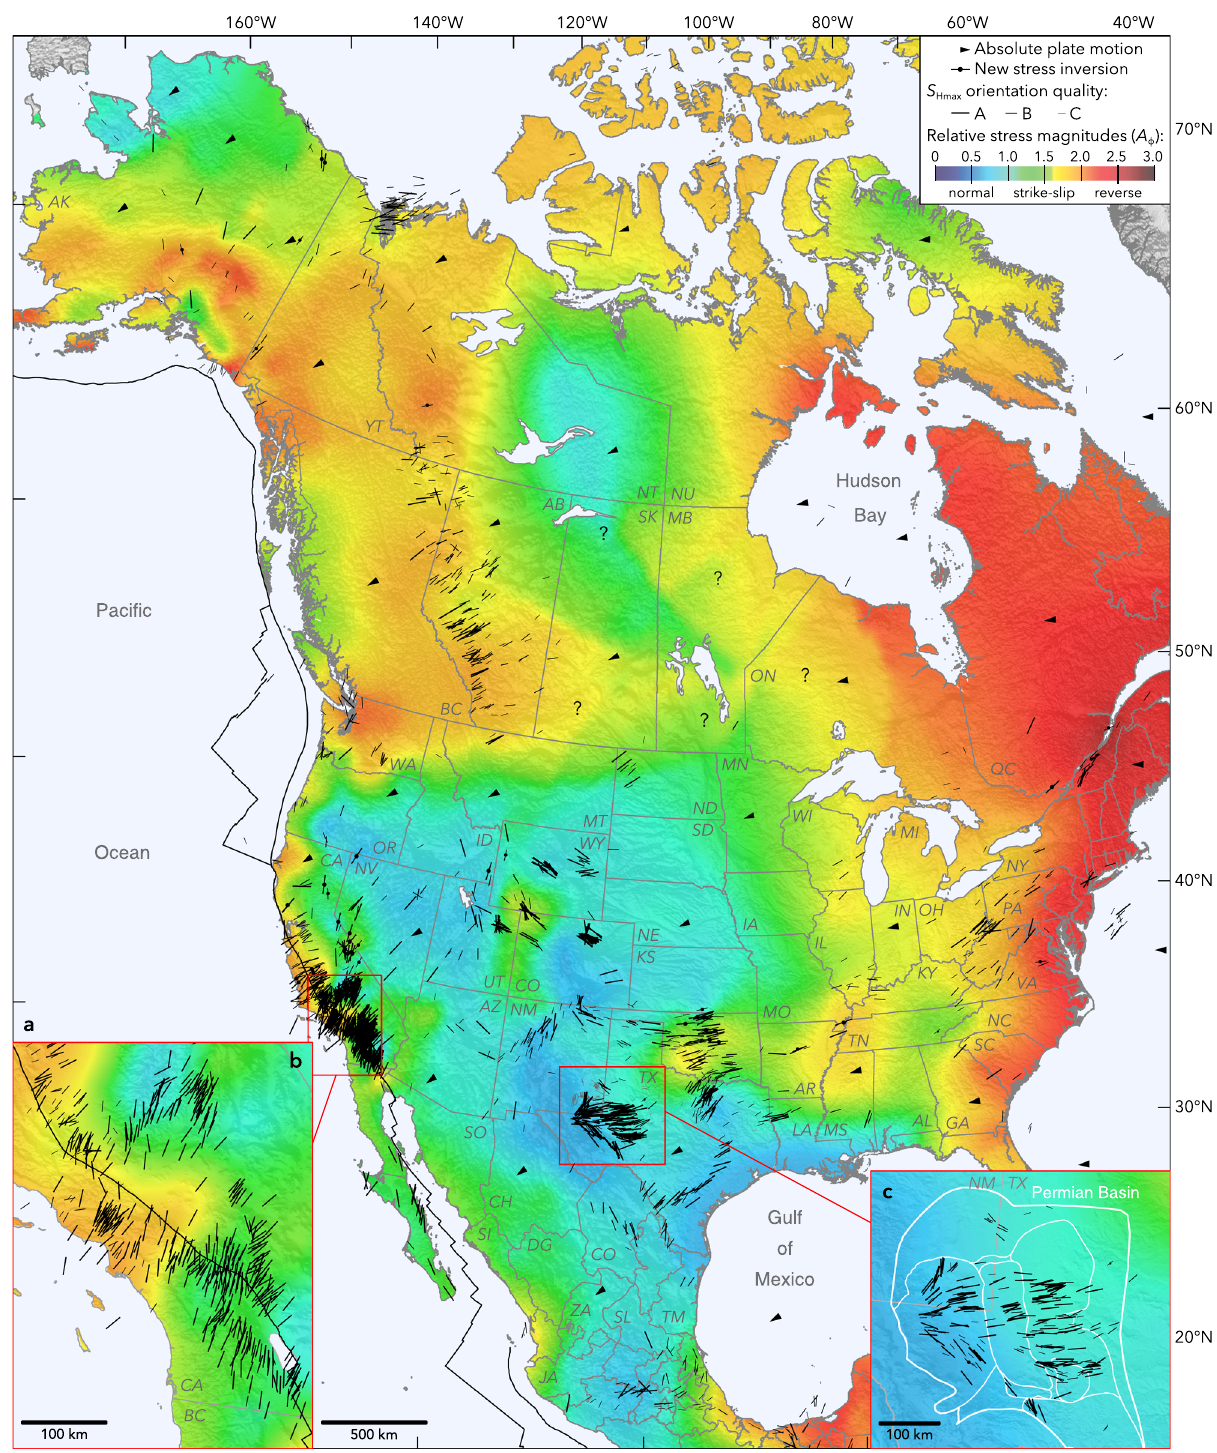
Fig. 1 State of stress in North America. Black lines are maximum horizontal stress ( S Hmax ) orientations and the colored background is the style of faulting (relative stress magnitudes) compiled from new and previously published measurements (see the text and Supplementary Information for data sources). S Hmax orientations span depths throughout the brittle upper crust (Supplementary Fig. 6). Relative stress magnitudes are classi classi fi cation system of Simpson 57 (see text and legend) and were interpolated (and slightly smoothed) from almost 2000 individual measurements. NNR- MORVEL56 absolute plate motion directions (as indicated by the pointed arrowheads) are from Argus et al. 30